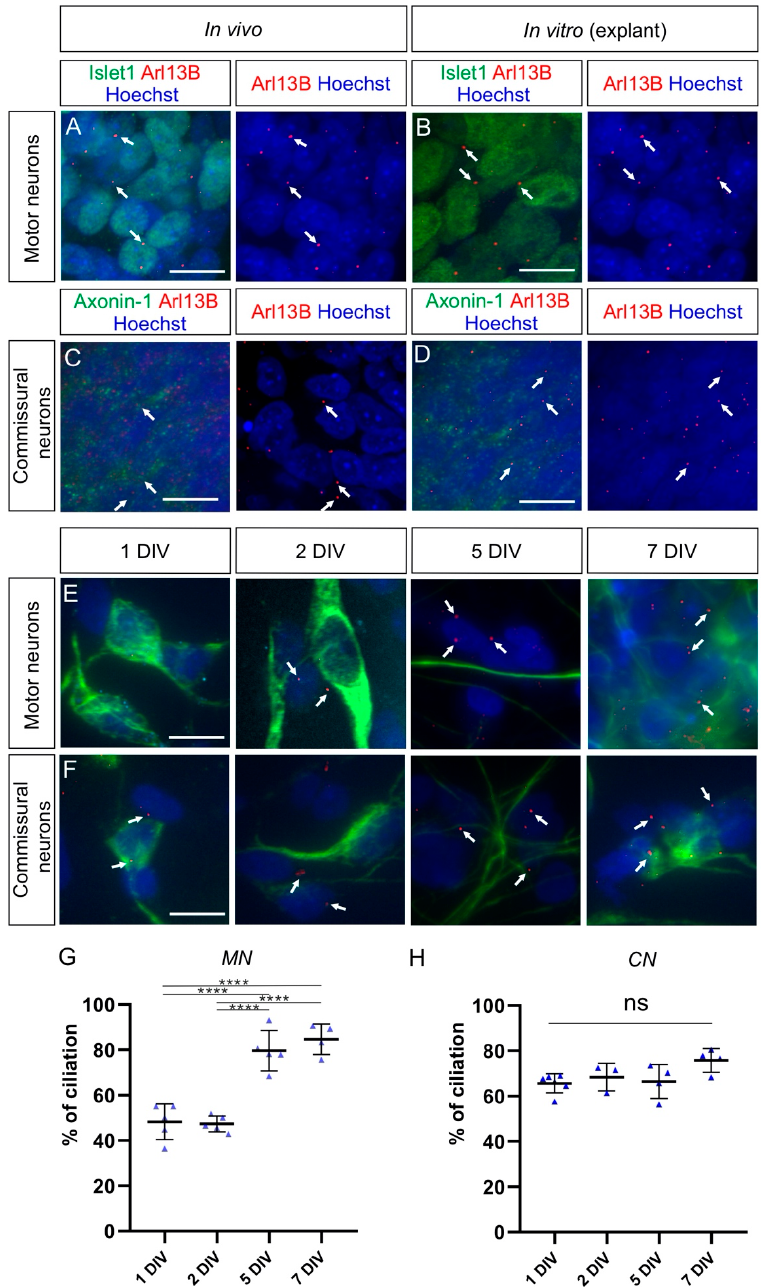
Figure 7. Commissural neurons and motor neurons possess a primary cilium in vivo and in explants cultures, but the ciliation rate is distinct for each population in dissociated cell cultures. ( A ) Islet-1-positive motoneurons located in the ventral horn of the spinal cord bore a primary cilium at HH26 in vivo (white arrows). ( B ) Motoneurons also possessed a primary cilium in explants cultured for 1 DIV (white arrows). ( C ) Axonin-1-positive commissural neurons, located in the dorsal horn of the spinal cord, carried a primary cilium at HH26 in vivo (white arrows). ( D ) Commissural neurons also possessed a primary cilium in explants cultured for 1 DIV (white arrows). ( E , F ) Cultured dissociated motoneurons ( E ) and commissural neurons ( F ), stained for neurofilament (NF-M), carried a primary cilium stained with Arl13B at different levels after 1, 2, 5, and 7 DIV (white arrows). ( G ) About half of the dissociated motoneurons carried a primary cilium after 1 and 2 DIV, and the ciliation rate significantly increased up to around 80% after 5 and 7 DIV. One-way ANOVA with Dunn’s multiple-comparisons test. ( H ) More than 65% of cultured dissociated commissural neurons carried a primary cilium after 1 DIV and kept it to a similar level up to 7 DIV. Kruskal–Wallis test with Dunn’s multiple-comparisons test. Error bars represent standard deviations. p ≥ 0.05, ns; p < 0.0001, ****. MN, motoneurons; CN, commissural neurons. Scale bars: 10 µ